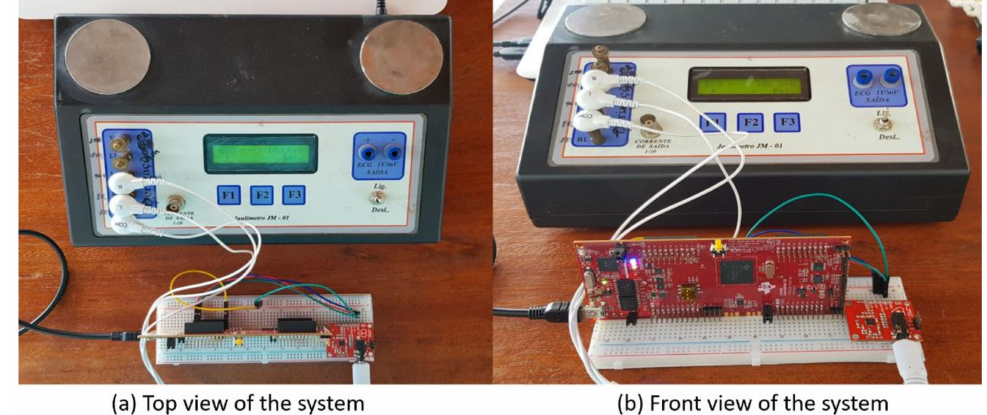
Figure 13. Prototype under analysis. ( a ) Top view of the prototype; ( b ) front view of the prototype.